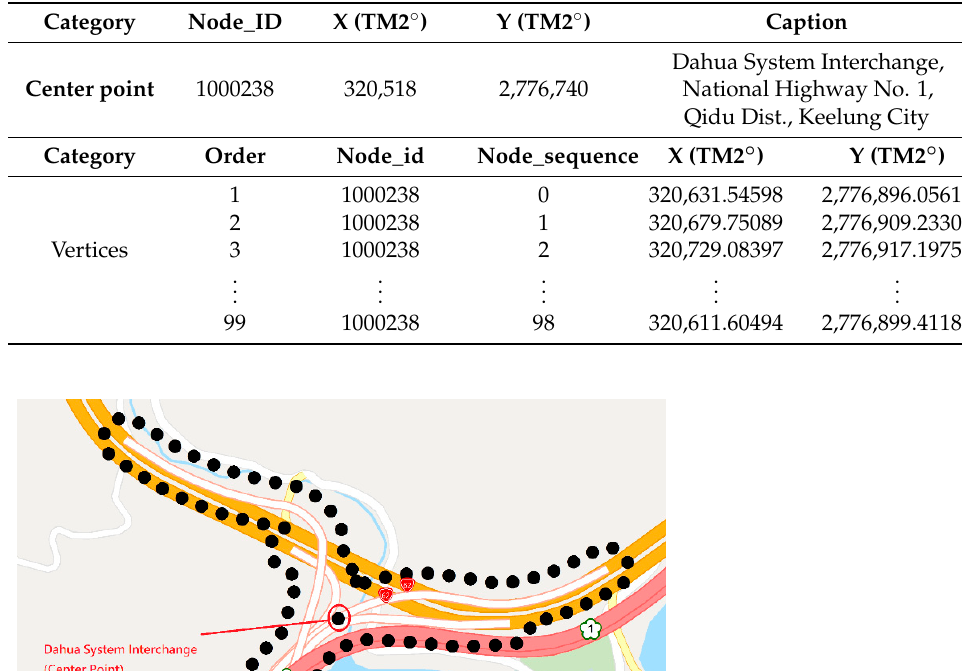
Table 3. An interchange example.